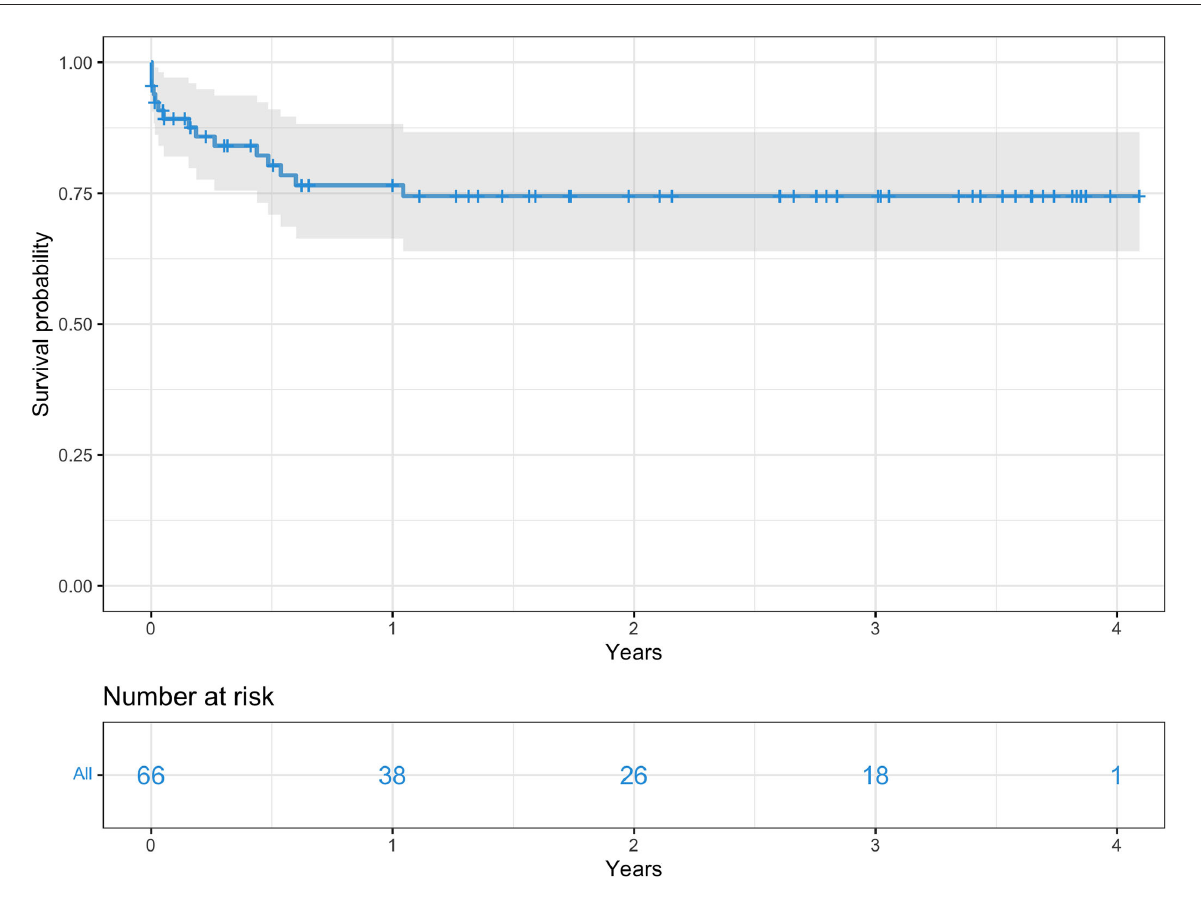
FIGURE2 Kaplan-Meier survival curve for the overall surgical